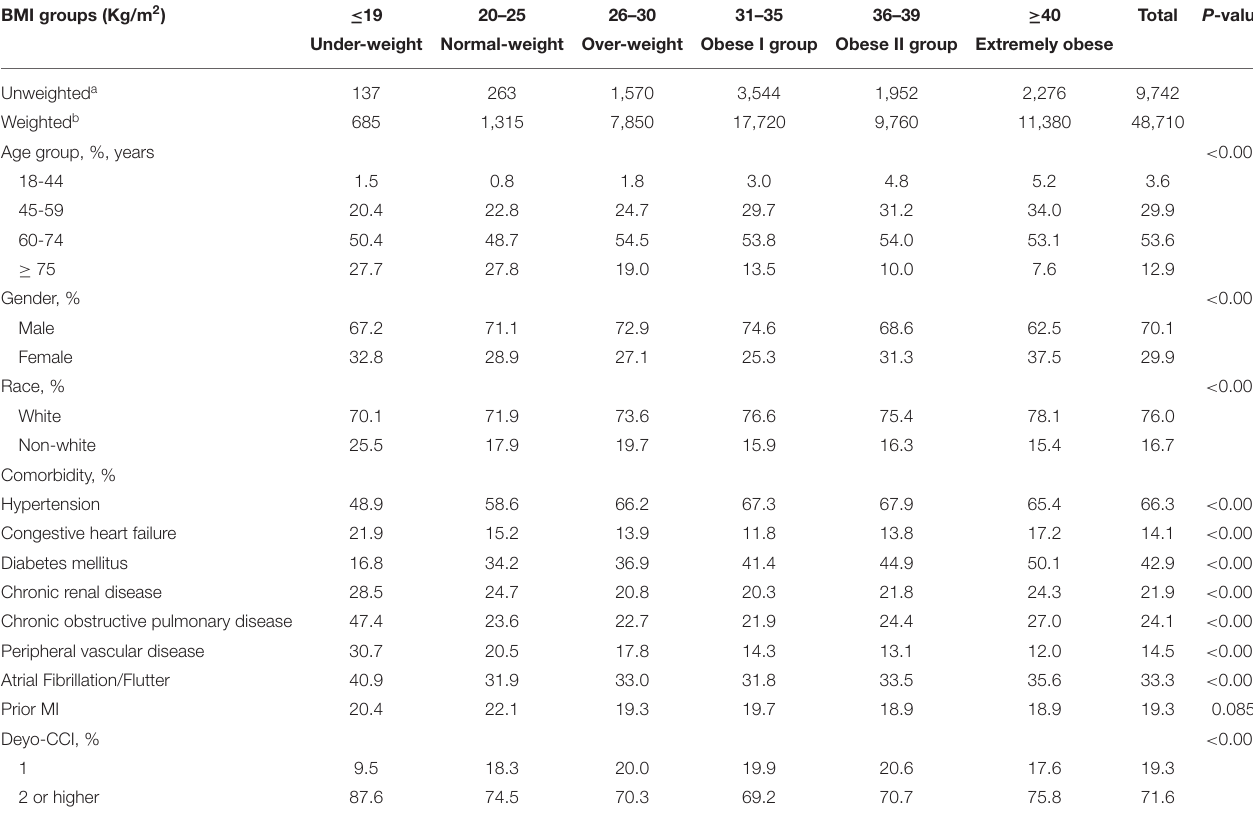
TABLE 1 | Frequency distribution of baseline characteristics by BMI group in CABG patients. BMI groups (Kg/m 2 )